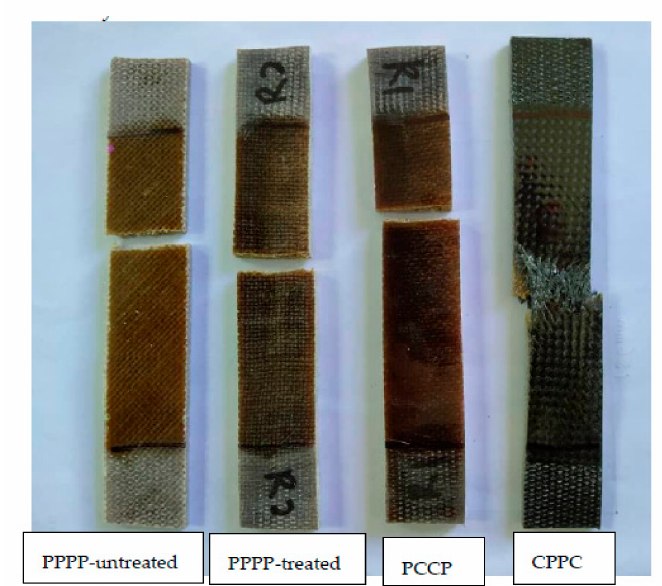
Figure 6. Fracture after tensile test for laminates with ply orientations [ ± 45 ◦ , 0 ◦ , 90 ◦ ].